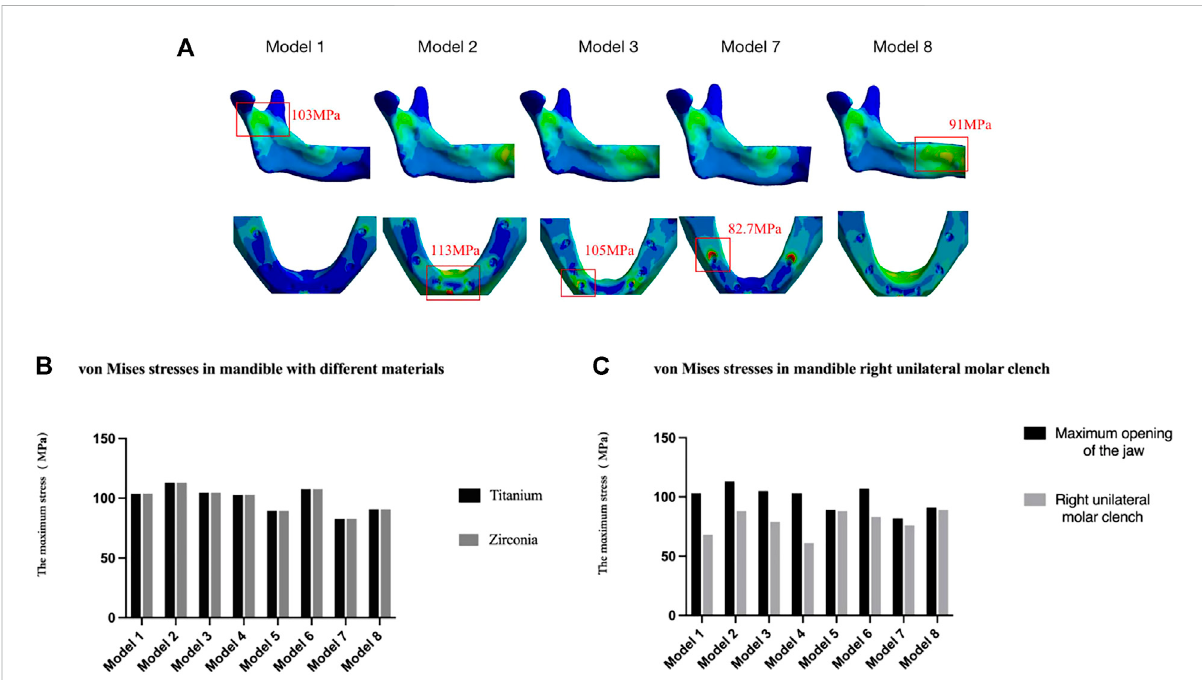
FIGURE 6 Von Mises stresses in the mandible of different denture designs. (A) Inside view of the mandibular ascending ramus and occlusal view of the mandibular body in different segmental frameworks. Only pseudo-color images of stress distribution for models 1, 2, 3, 7, and 8 are shown in Figure 6A due to the distributionof thestress in thejaws is thesame for the same segmental frameworks (model 1 vs. 4, model 2 vs. 5, model 3 vs. 6). (B) Different framework materials and (C) right unilateral molar